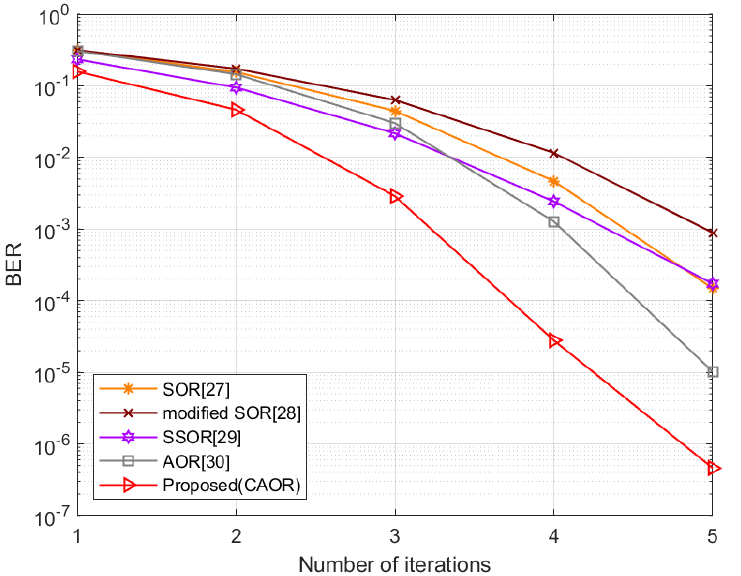
Figure 8. BER performance vs. number of iterations with N R × N T = 64 × 16 and SNR = 50 dB.